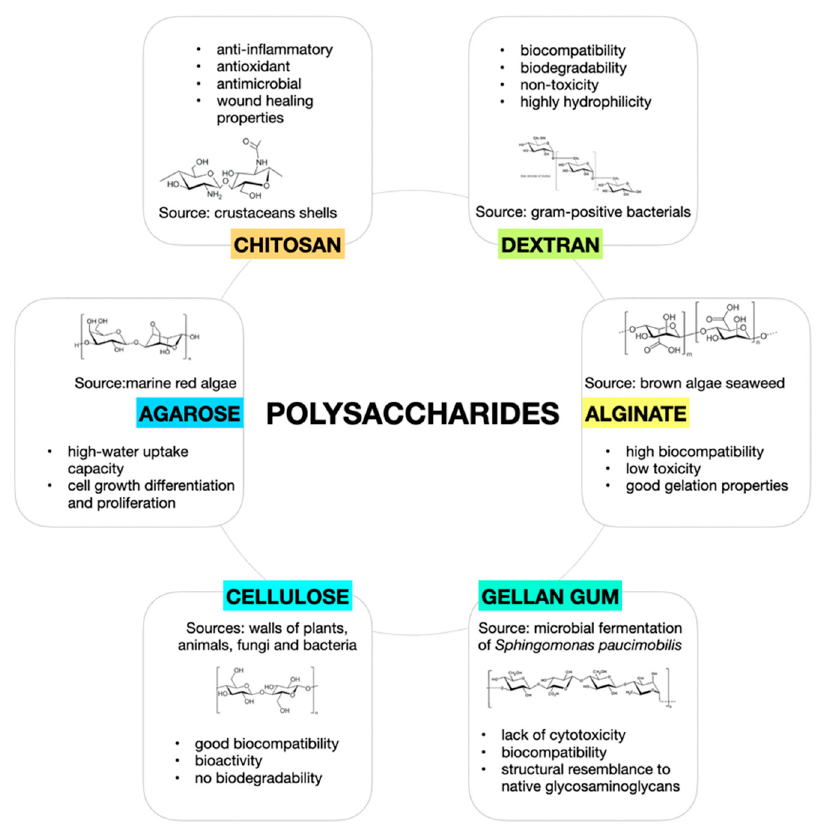
Figure 2. Graphical description of main polysaccharides, their principal sources, and